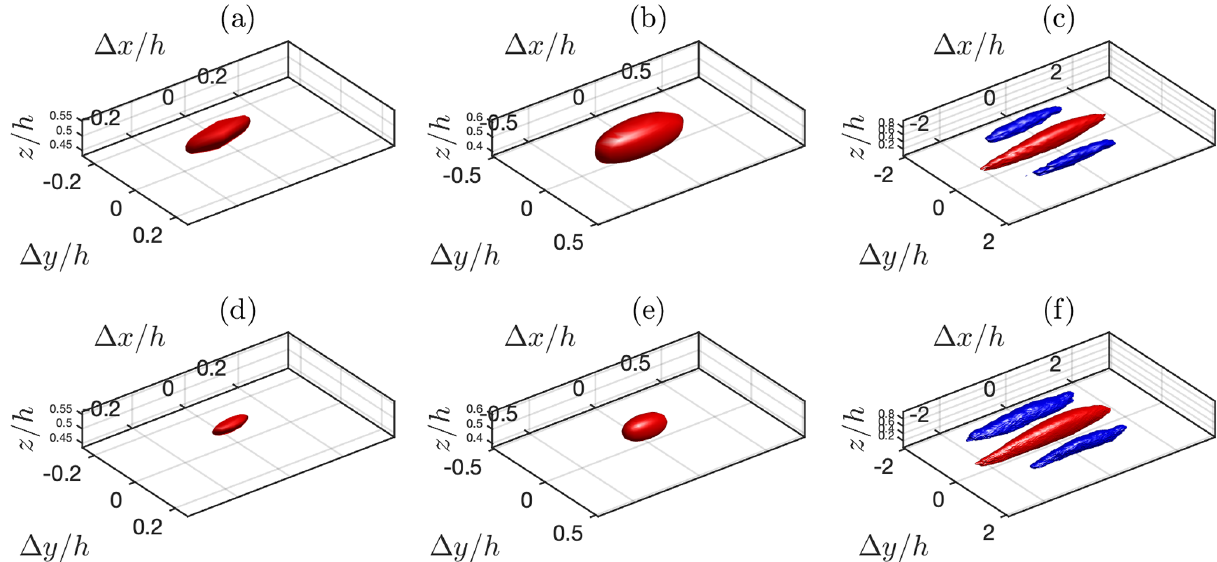
Figure 10. Conditionally averaged flow field from simulations FV64 (a) , FV64* (b) , PSFD64 (c) , FV160 (d) , FV160* (e) , and PSFD160 (f) . The conditional average is computed as in Fig. 9. Red isosurfaces show positive fluctuations ( > 0 . 7, top; > 0 . 65, bottom); blue isosurfaces show negative fluctuations ( < − 0 . 55, top; < − 0 . 5,